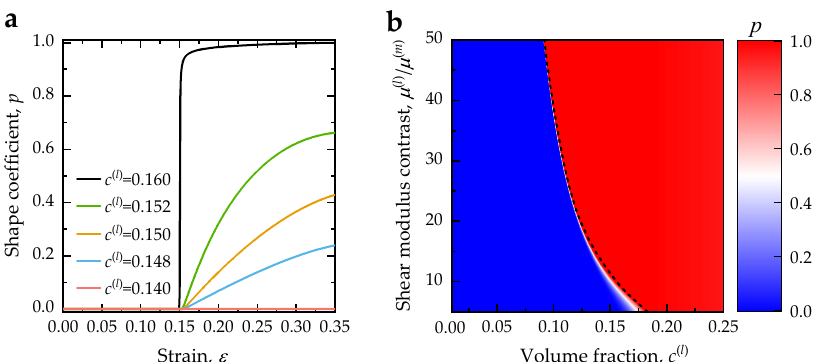
Fig. 4 Pattern transition and composite morphology diagram. a Evolution of shape coef fi cient as functions of applied deformation levels for layered composites with shear moduli contrast μ ð l Þ = μ ð m Þ ¼ 10 . b The shape coef fi cient map for layered composites with various shear modulus contrasts and stiffer layer volume fractions. The value of the shape weight coef fi cient p is evaluated at the well-resolved post- buckling stage of strain-level ε = ε cr +